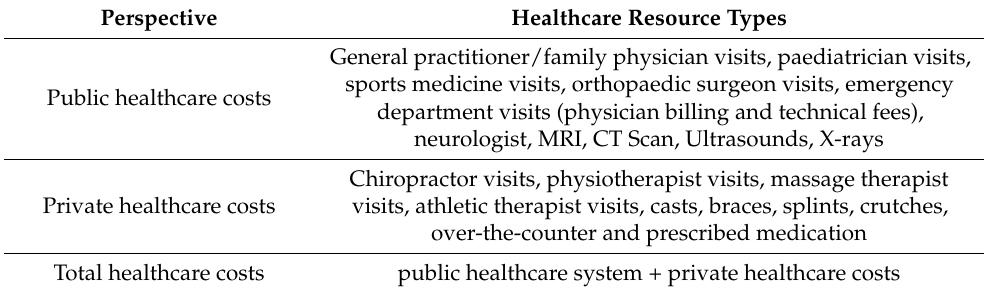
Table 1. Healthcare resource types included in each perspective.